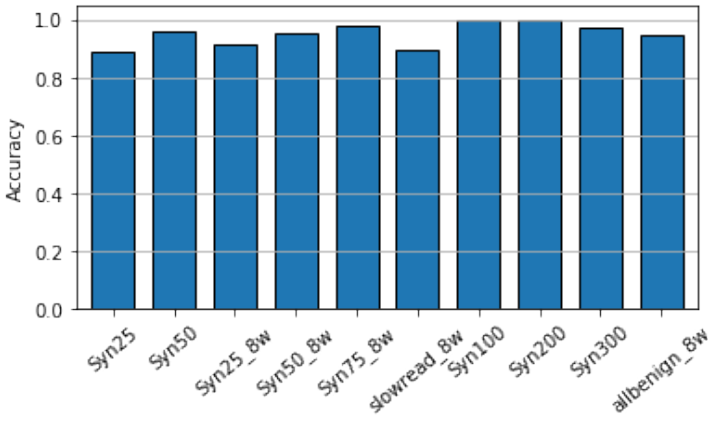
Figure 8. LSTM-RF detection accuracy for different traffic types.